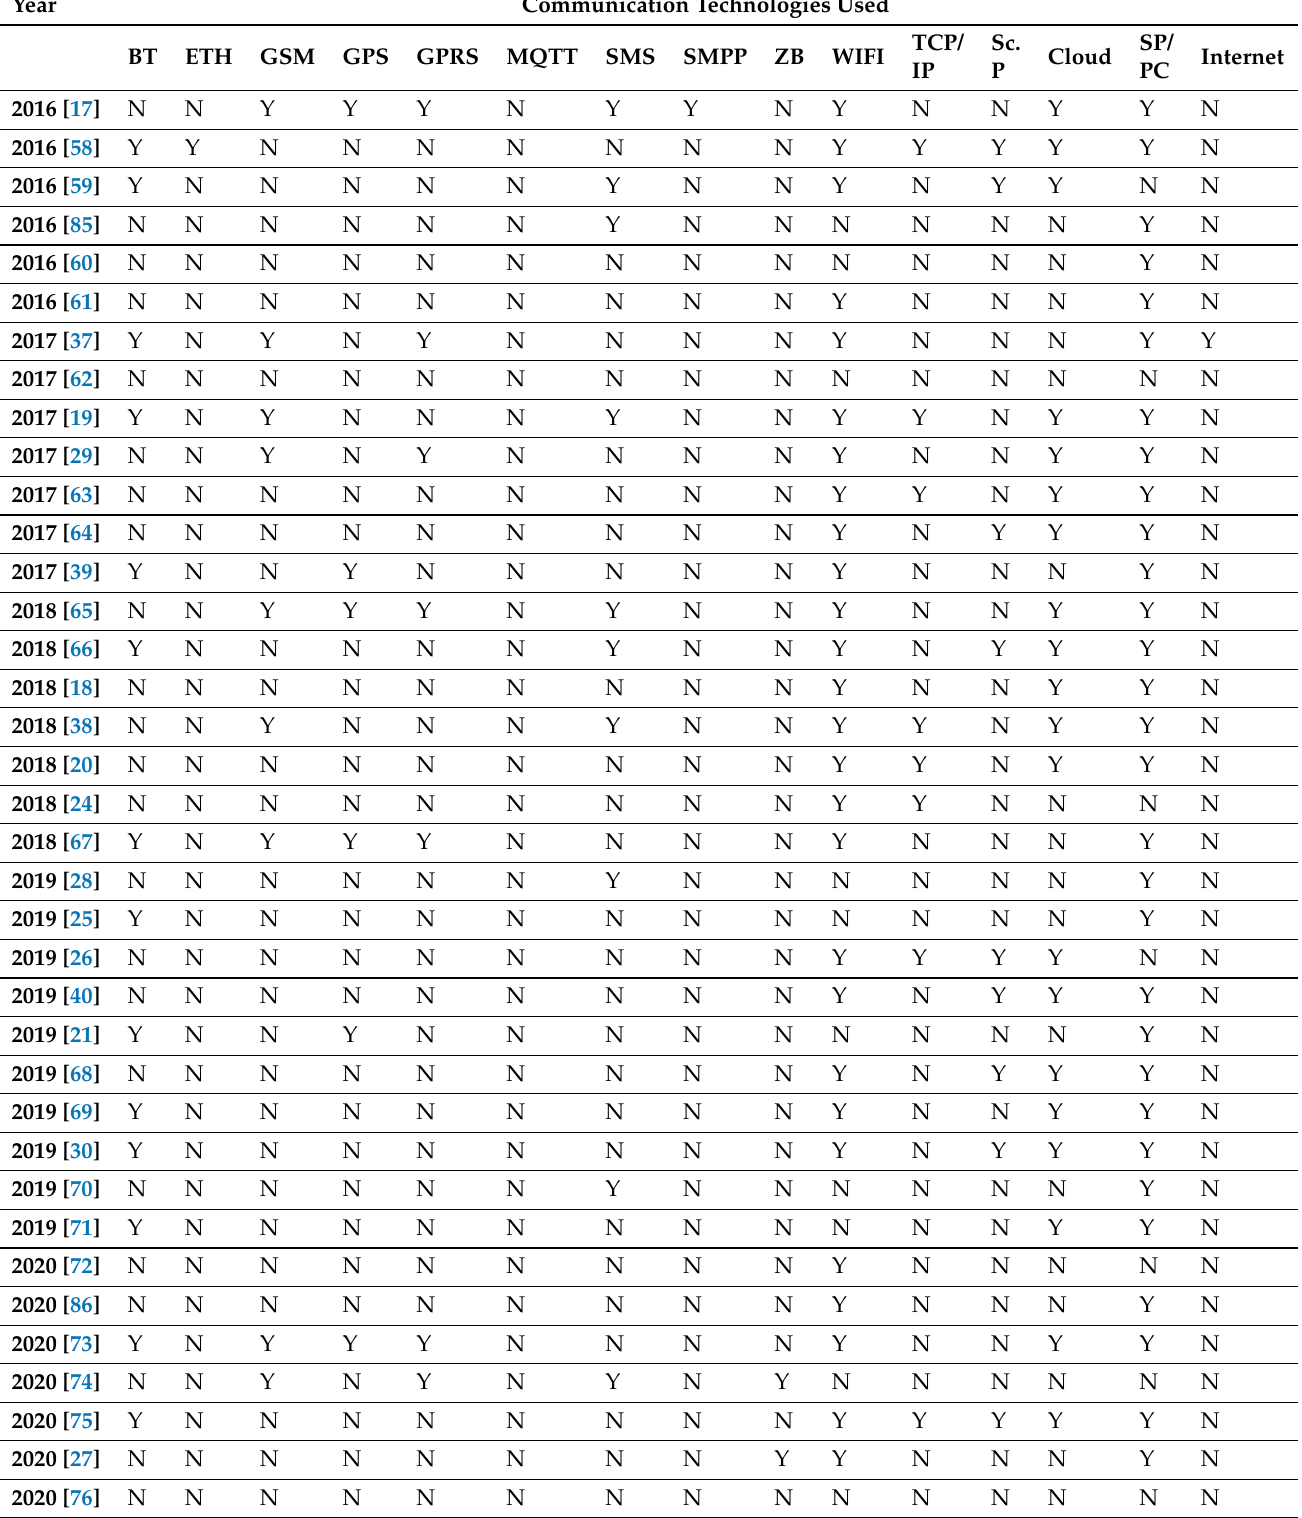
Table 11. Communication technologies used in previous